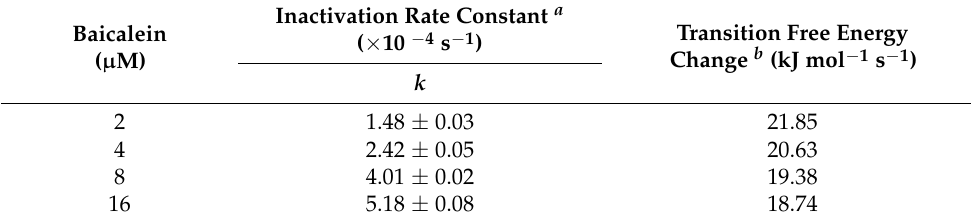
Table 1. Inactivation rate constants for AChE with baicalein.